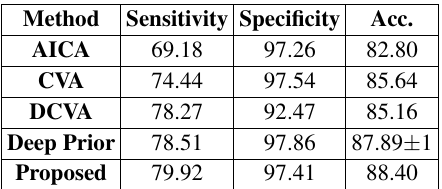
Patch length Sensitivity Specificity Acc.